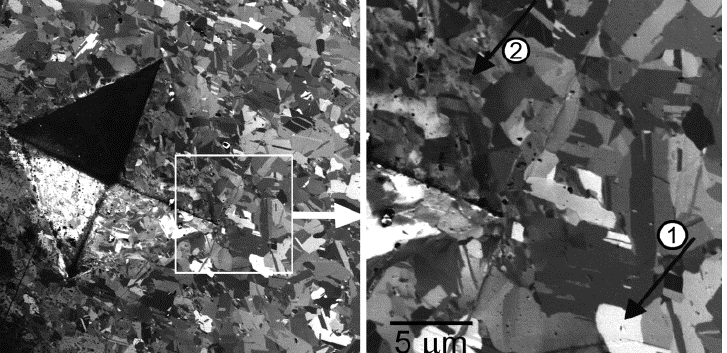
Figure 14. Micrograph of a Vickers indent in polycrystalline Cu with the magnified part comprising relaxed grains with a constant image signal (arrow 1) as well as deformed grains with internal signal variations (arrow 2). (scanning low energy electron microscopy (SLEEM) mode at 500 eV, which is capable of visualizing the strain-caused signal variations inside crystal grains on the indent